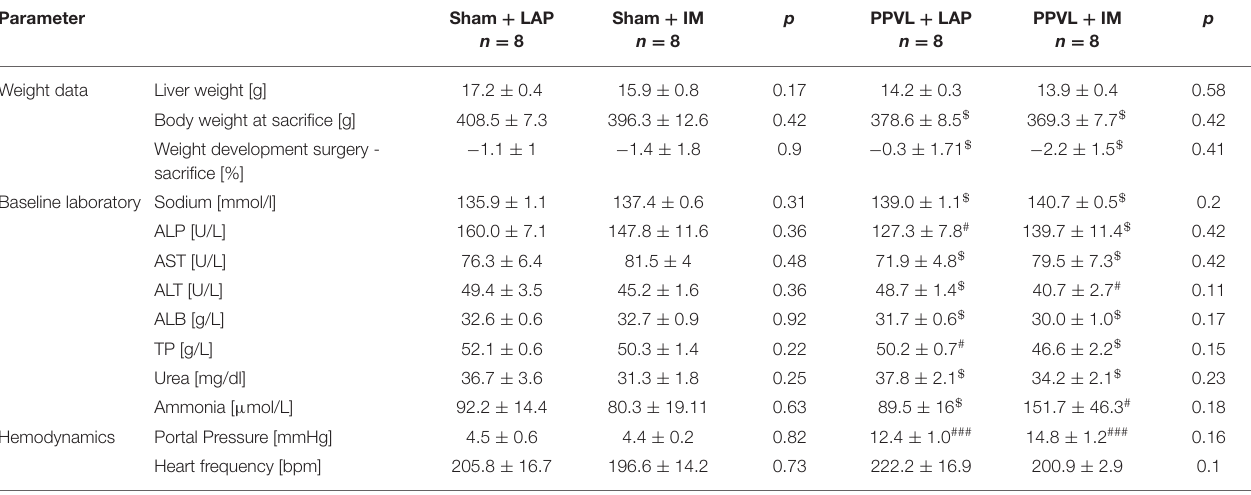
TABLE 1F | General characteristics and clinical data of rats undergoing Sham/PPVL at sacrifice 7 days after IM/LAP.